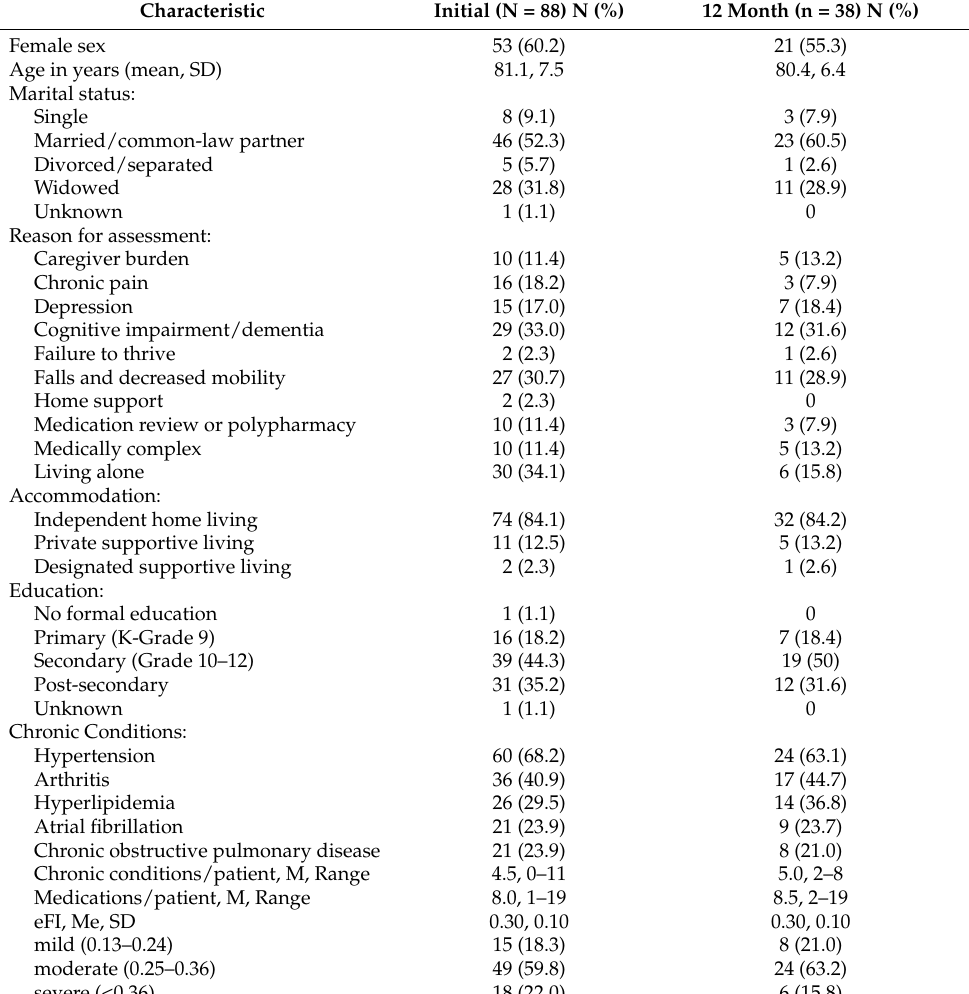
Table 2. Characteristics of patients at initial SCH and at 12-month